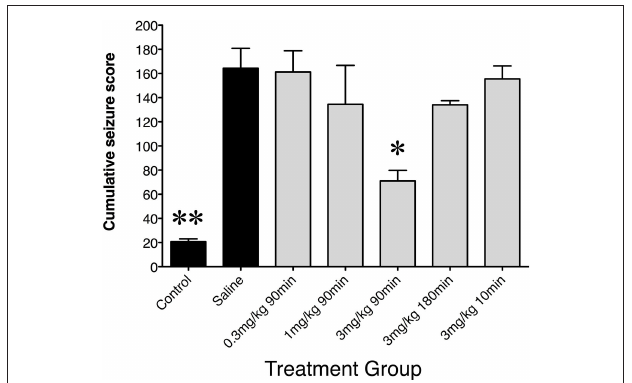
FIGurE 1 | Cumulative seizure scores following saline or low-dose GYKI 52466 preconditioning. Histograms show mean ± SEM cumulative seizure scores. Labels along the x axis indicate preconditioning paradigm. All groups received KA (10 mg/kg) except control animals, which received a second saline injection. Scores were calculated from the 2-h monitoring period following KA injection. * p < 0.05 vs. Saline, ** p < 0.01 vs. Saline.